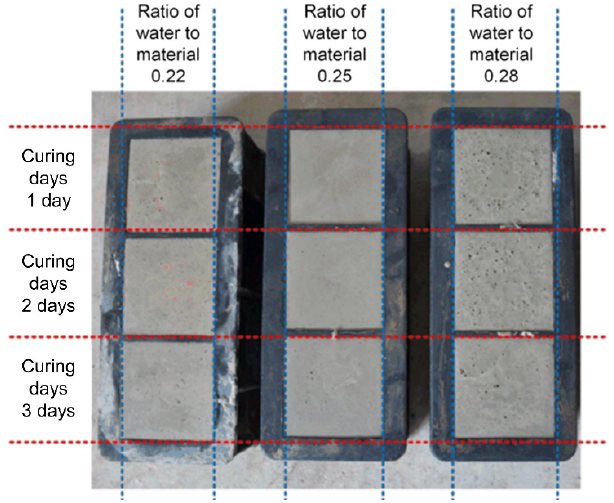
Figure 2. Test scheme for compressive